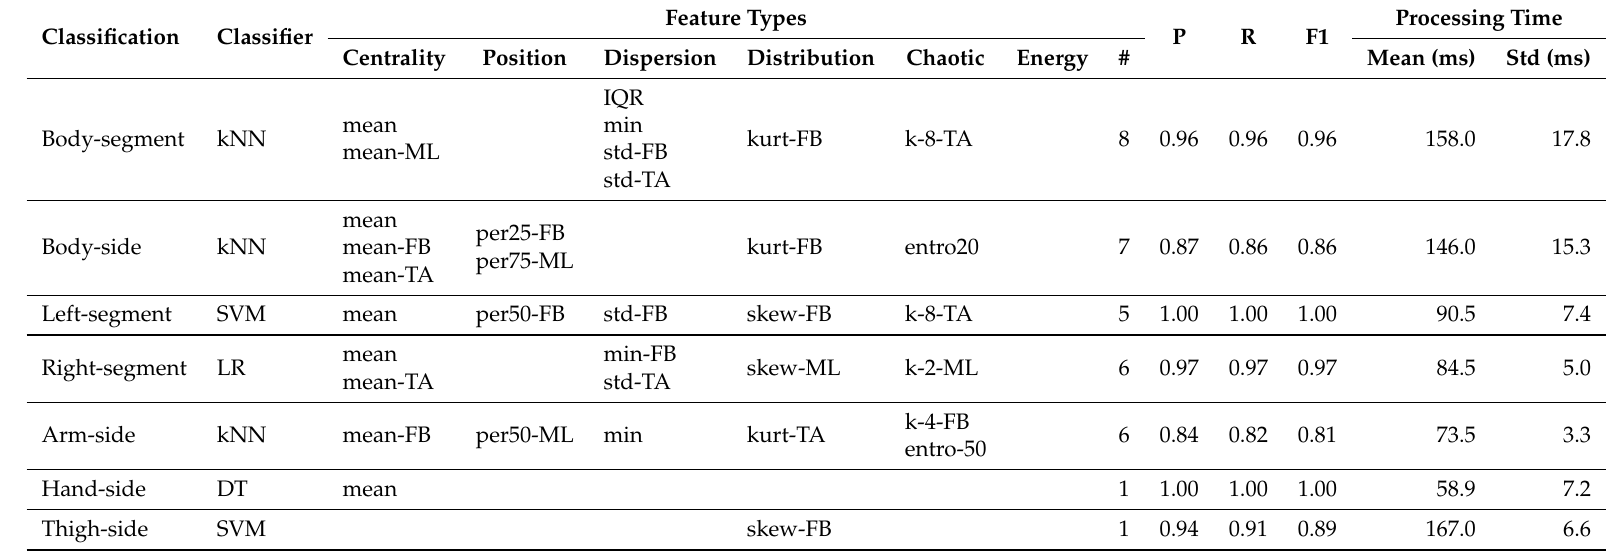
Table 8. The performance of selected features and classifiers using